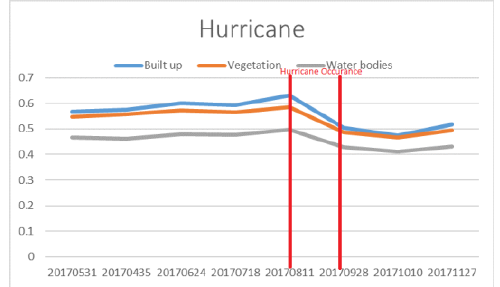
Figure 3: Land-use class graphs showing coherence loss over time for different land-uses